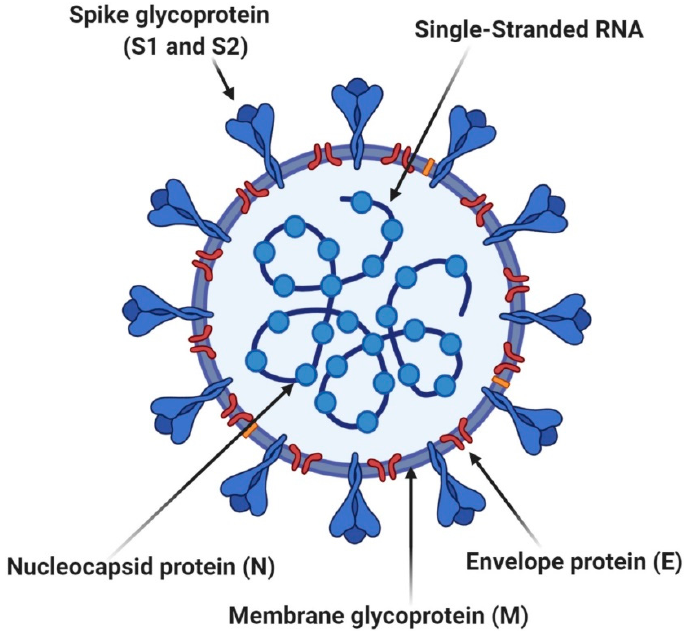
Figure 4. Cross-sectional model of SARS-CoV-2. Adapted from [60], published by AMER PUBLIC HEALTH ASSOC INC, 2021.